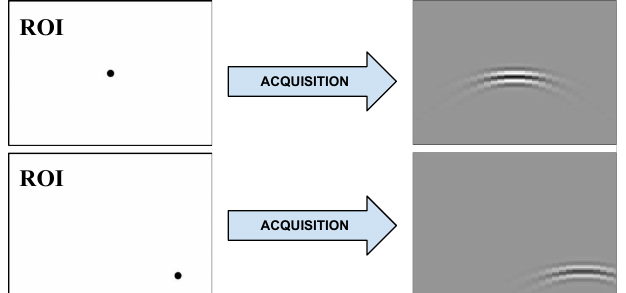
Figure 1. Acquisition of the point spread function (PSF). For each position ( x , z ) of the unity amplitude scatterer within the region of interest (ROI) (left side), an M -sample response y ( x , z ) ∈ R M (arranged as an M -pixel image on right side) is generated by the acquisition model. The set of all possible PSFs within the region of interest form a manifold M onto the data